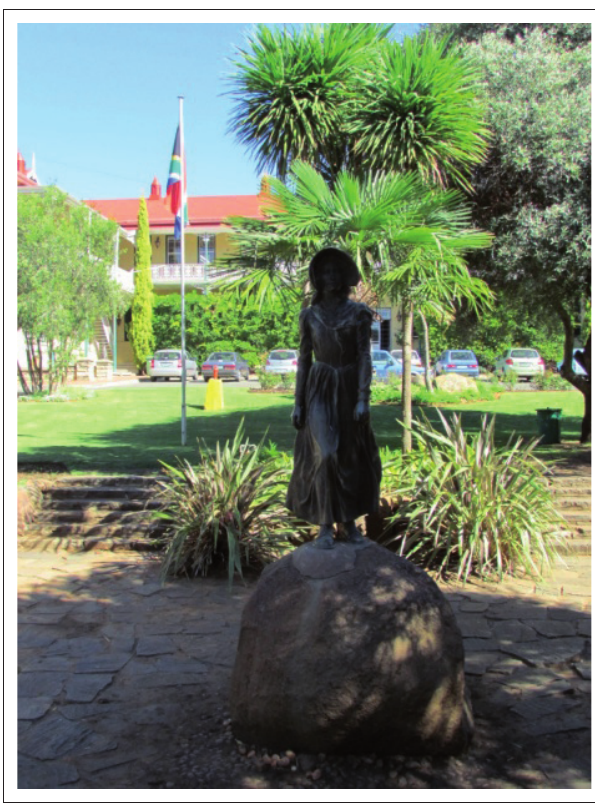
FIGUUR 5: Die Voortrekkernooientje met Le Roux-huis in die agtergrond.